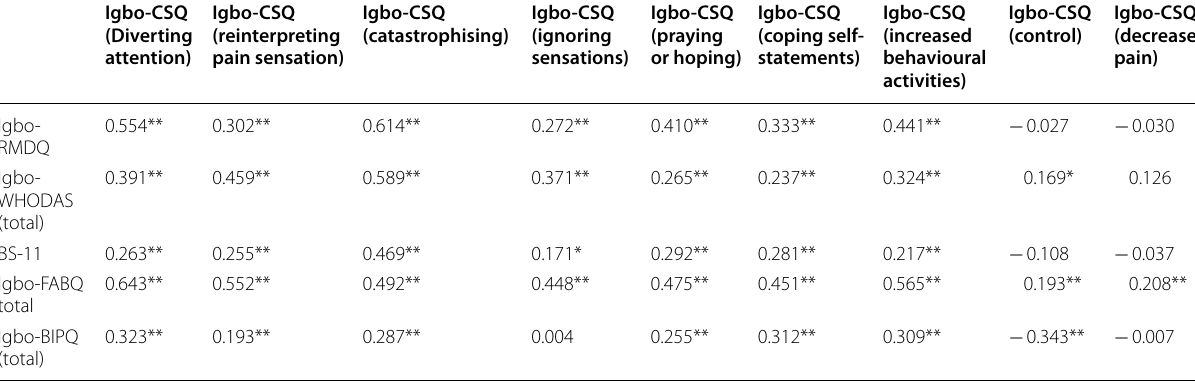
Table 3 Spearman’s correlation between Igbo‑CSQ subscales, and self‑reported back pain specific disability (Igbo‑RMDQ), self‑ reported generic disability (Igbo‑WHODAS), self‑reported numeric pain intensity (BS‑11), self‑reported fear avoidance beliefs (Igbo‑ FABQ), and self‑reported illness perceptions